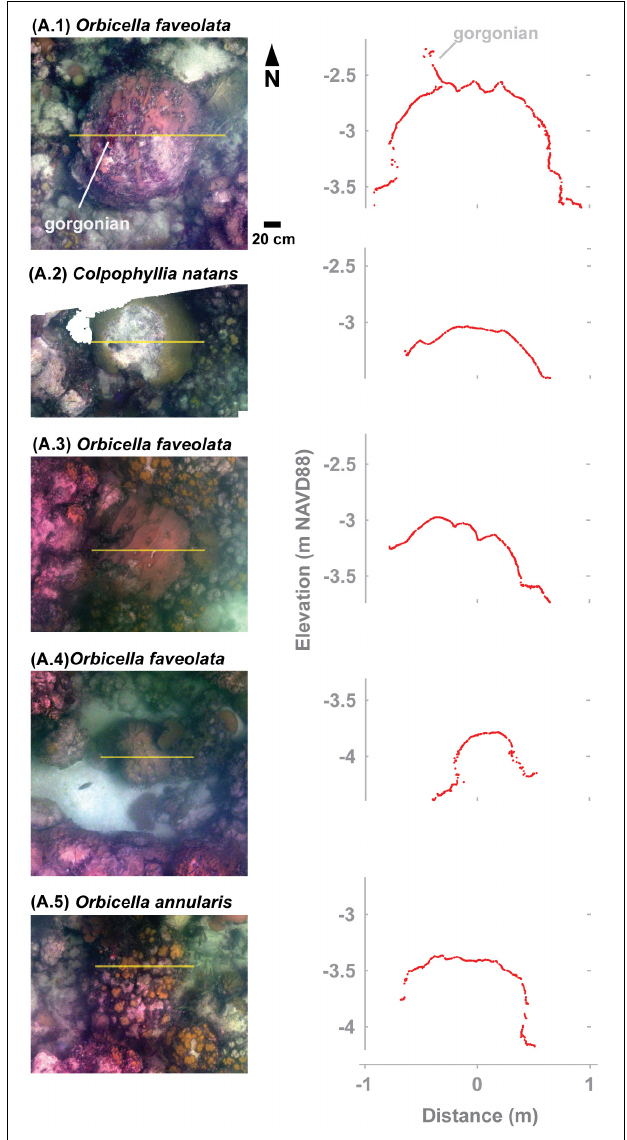
FIGURE 7 | Photo mosaics and elevation profiles for several coral heads mapped at the Cheeca Rocks site and highlighted by locator boxes 1–5 shown in Figure 6A . Coral species include Mountainous Star Coral ( Orbicella faveolata ), Boulder Brain Coral ( Colpophyllia natans ), and Boulder Star Coral ( Orbicella annularis ). The profile in (A) includes a sea fan, or gorgonian ( Gorgonia ventalina ). Profiles were derived from the original Structure-from-Motion (SfM) point cloud using all points within ± 1 mm of the profile